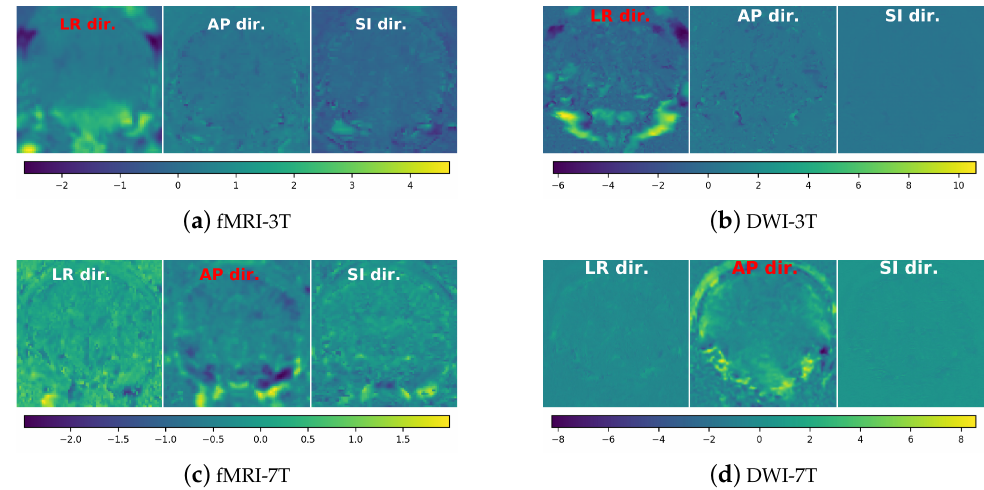
Figure 5. Samples of three predicted displacement fields (in voxel) of TS-Net from the four test sets. In each subfigure, left image : displacement field in the left–right (LR) direction; middle image : displacement field in the anterior–posterior (AP) direction; right image displacement field in the superior–inferior (SI) direction. The dominant phase-encoding dimension (direction) is shown in red text; the other two other dimensions are shown in white